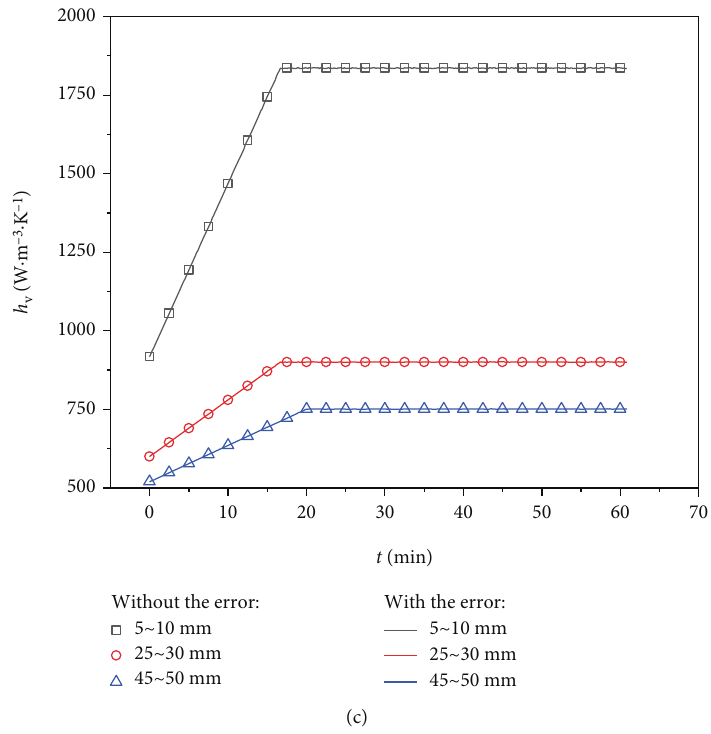
Figure 11: In fl uence of the measurement error on the heat transfer coe ffi cient h (c) error of the bed